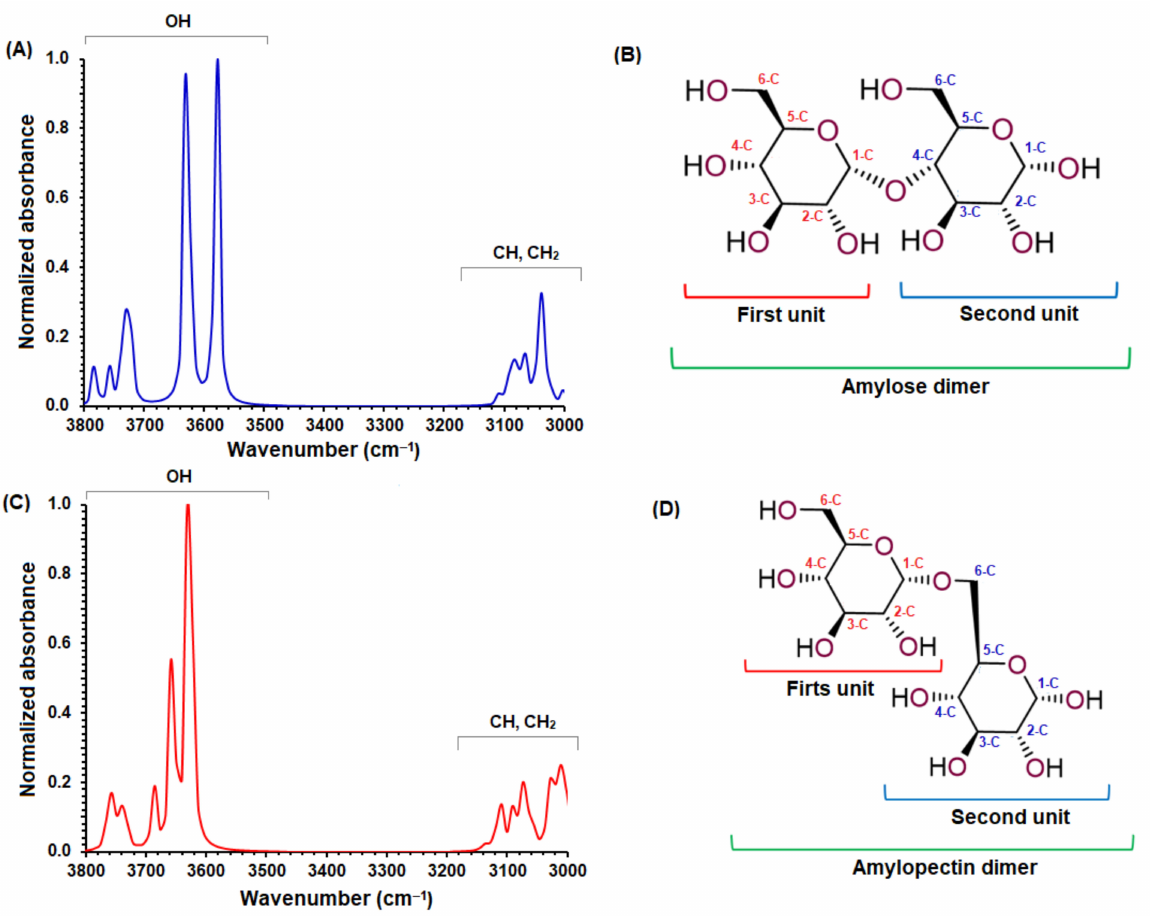
Figure 3. Theoretical spectra of amylose and amylopectin dimers ( A , C ) and their respective structures ( B , D